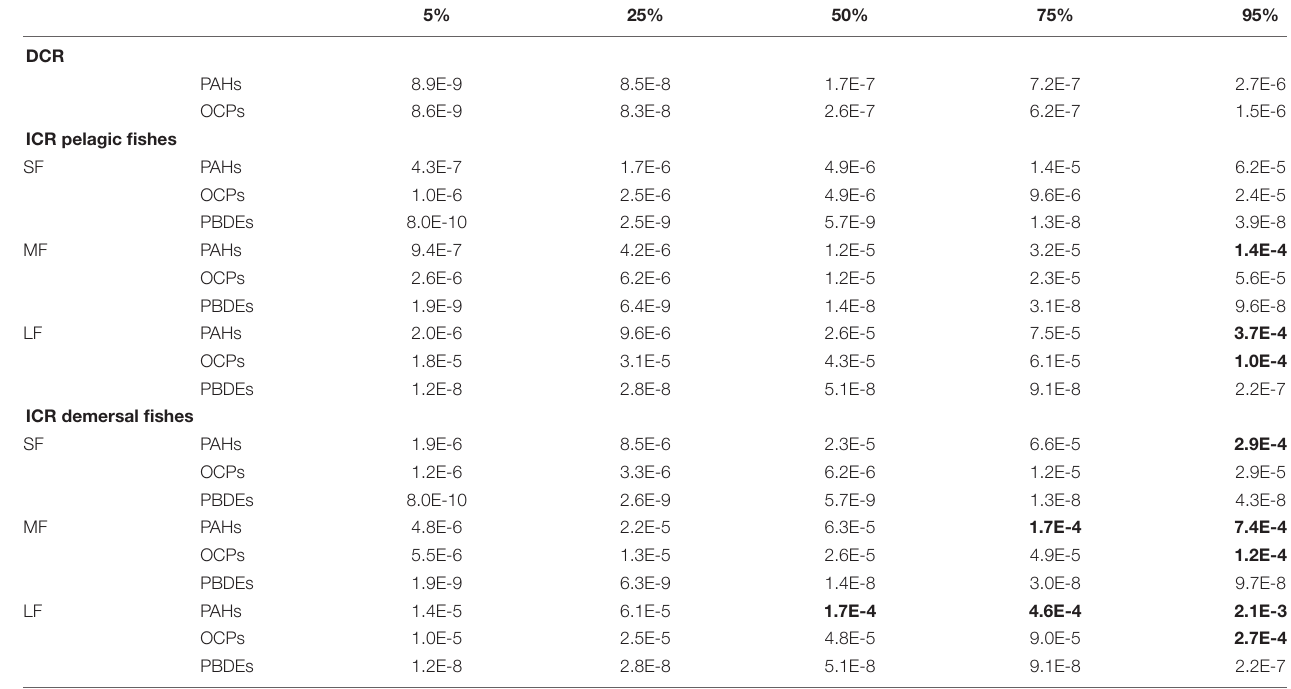
TABLE 7 | Monte Carlo simulation, probabilistic distribution of DCR and ICR, statistical values